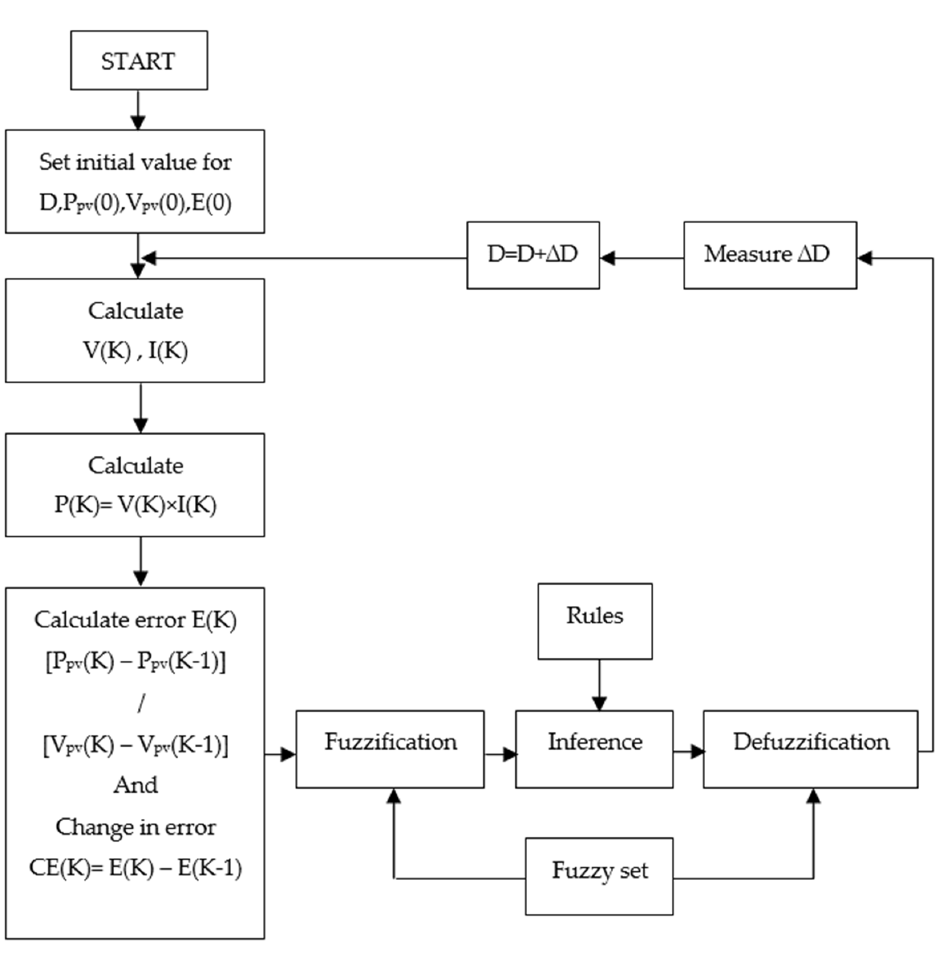
Figure 7. Flowchart of fuzzy logic controller.